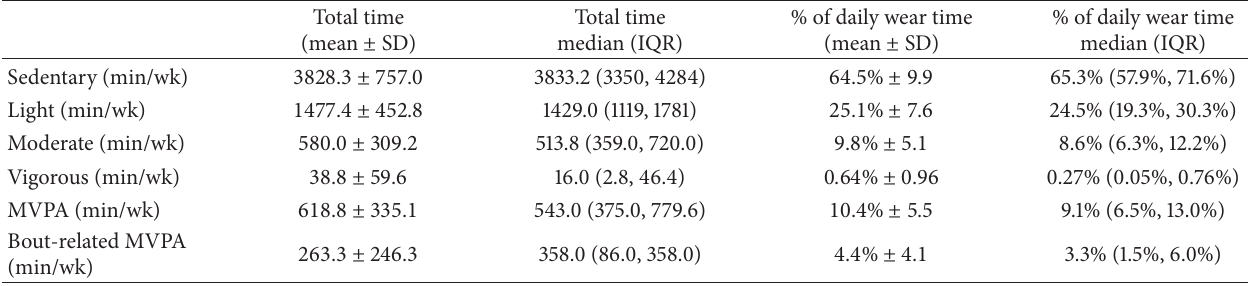
Table 1: Objectively assessed time spent in physical activity and sedentary behaviors among 595 participants enrolled in the SNAP